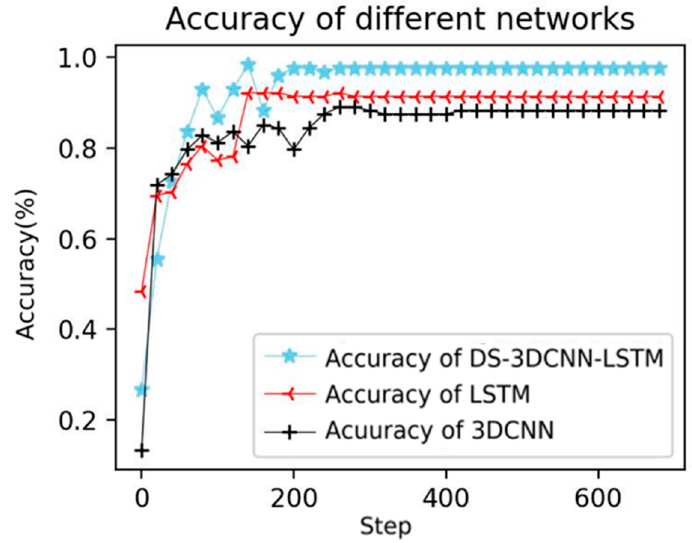
Figure 15. Accuracy of different networks.